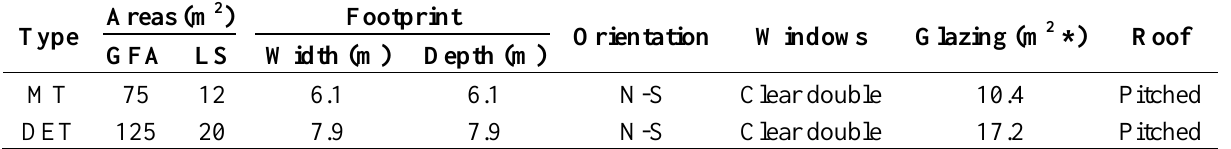
Table A1. Seasonal house energy modeling—main parameters.